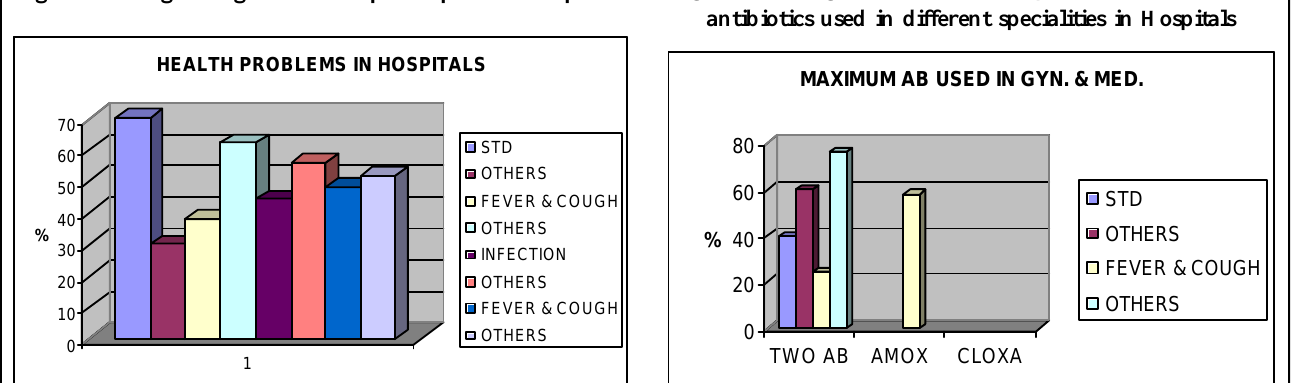
Fig. 2 : Maximum Health Problems